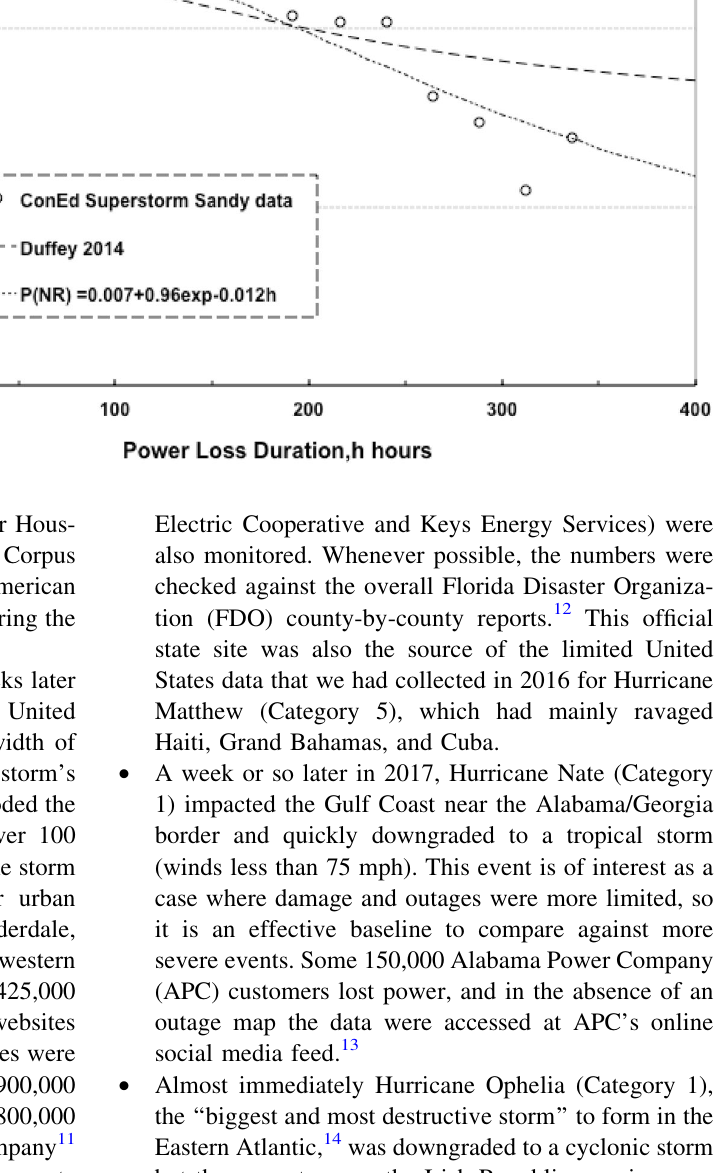
Fig. 1 Comparison of the initial scoping test of outage restoration prediction models (dashed lines) and Superstorm Sandy data